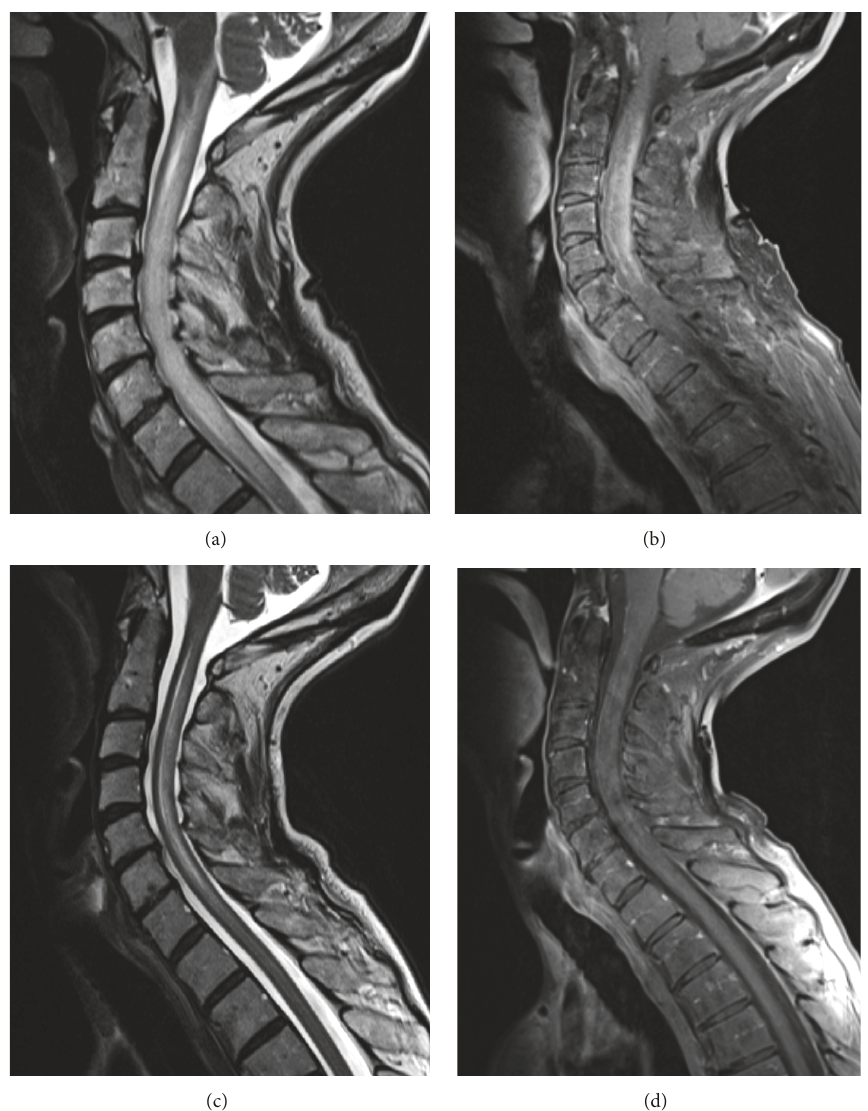
Figure 1: (a) Distinct oedema of the cervical spinal cord on T2-weighted sequences with spinal cord swelling and expansion into the brainstem. (b) Distinct gadolinium enhancement of the cervical spinal cord on T1-weighted sequences with cord swelling. (c) Regressive edema in the cervical spinal cord after 5 days of methylprednisolone followed by plasmapheresis and immunoadsorption. (d) Regressive gadolinium enhancement in the cervical spinal cord after